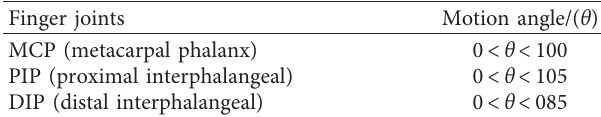
Table 1: Motion angle of the MCP, PIP, and DIP joints. Finger joints Motion angle/( θ